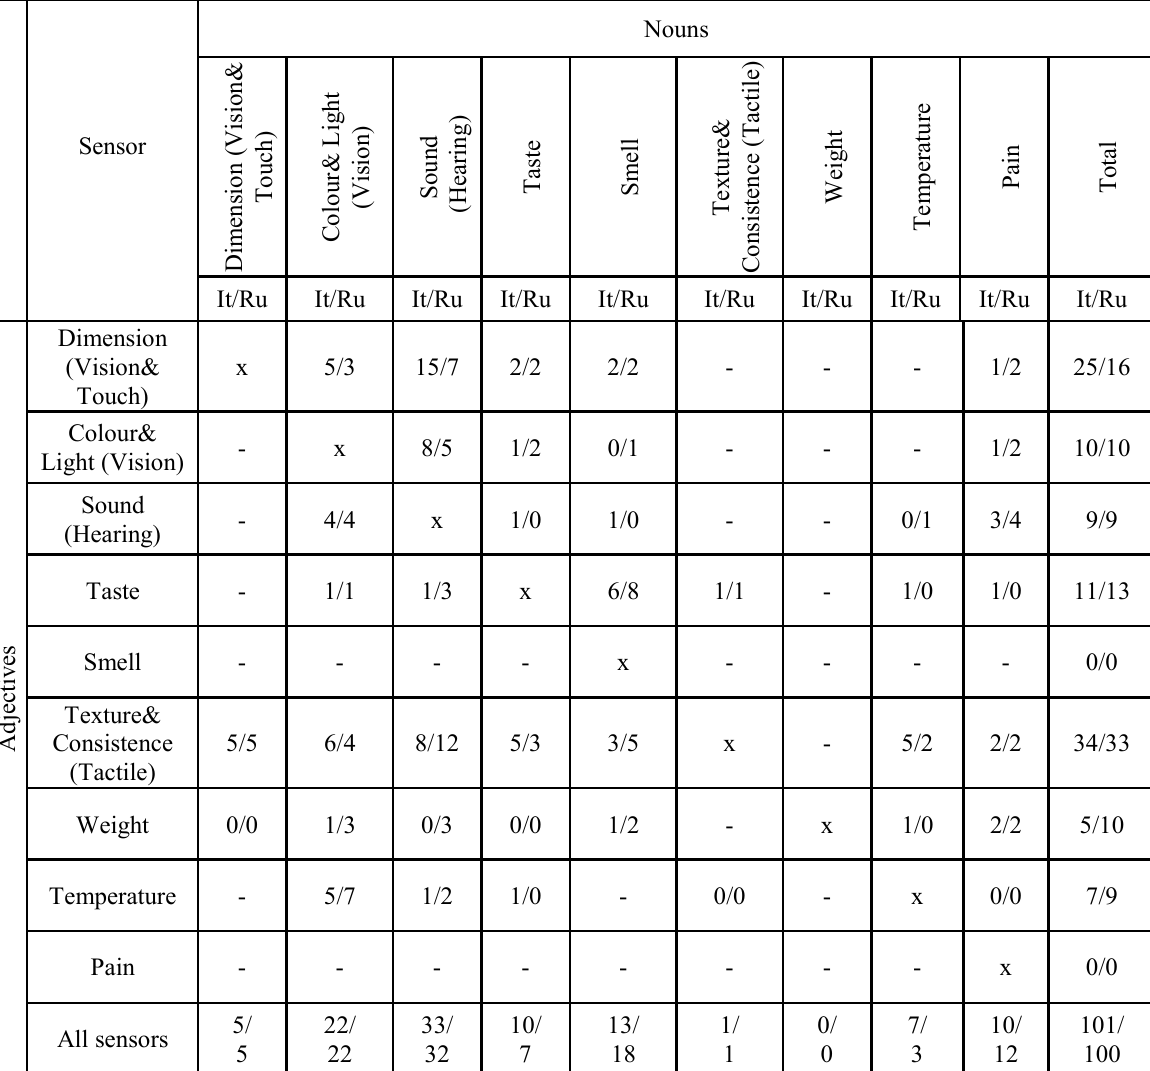
Table 2. – Total estimate of all ‘pure’ synaesthetic